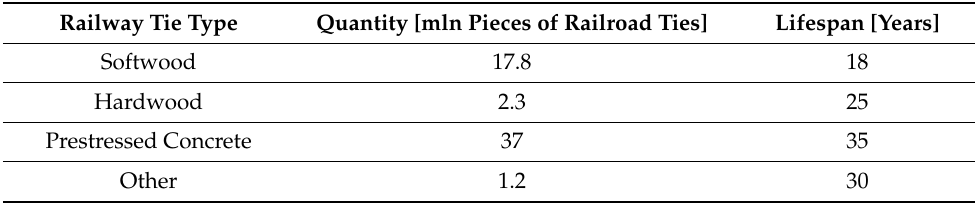
Table 1. Railway ties in Poland based on